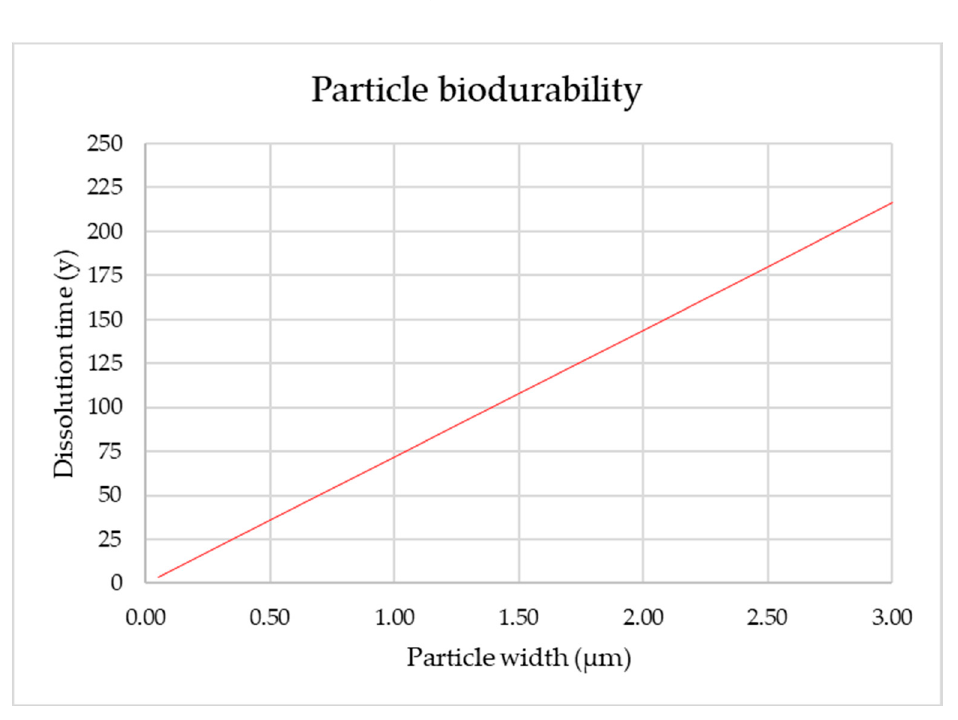
Figure 10. Biodurability calculated for widths ranging from 0.05 µm to 3 µm. The red line represents the linear Equation (3).